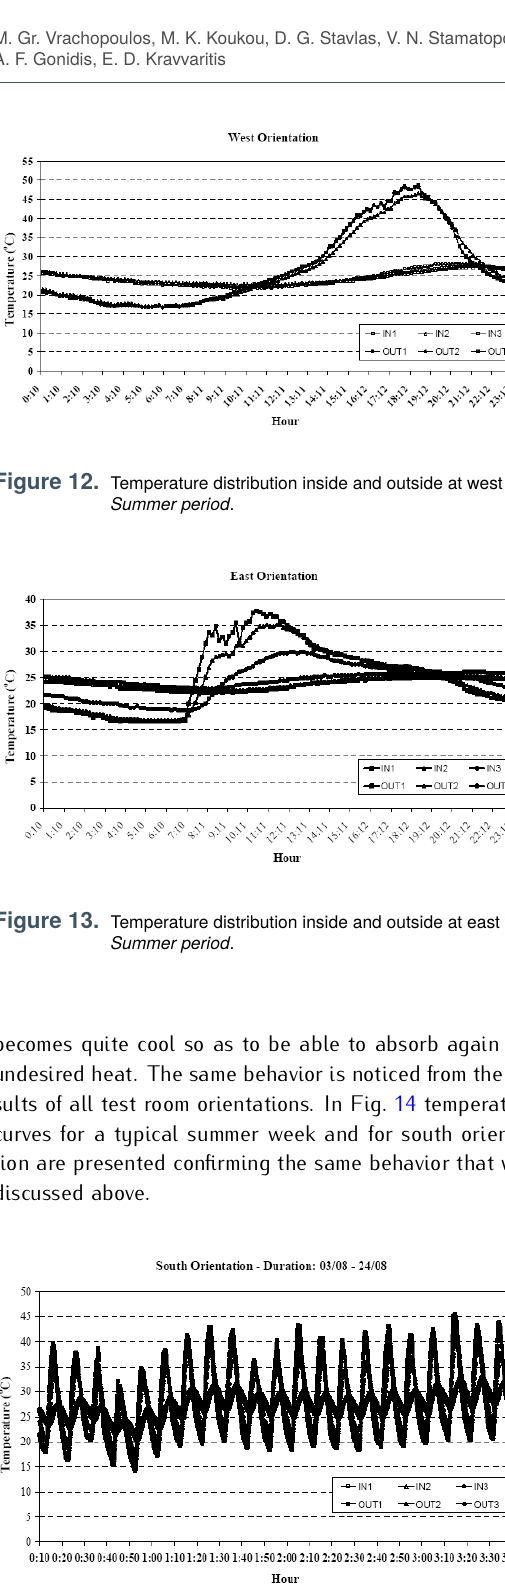
Figure 14. Temperature distribution inside and outside at south wall in August Summer period .